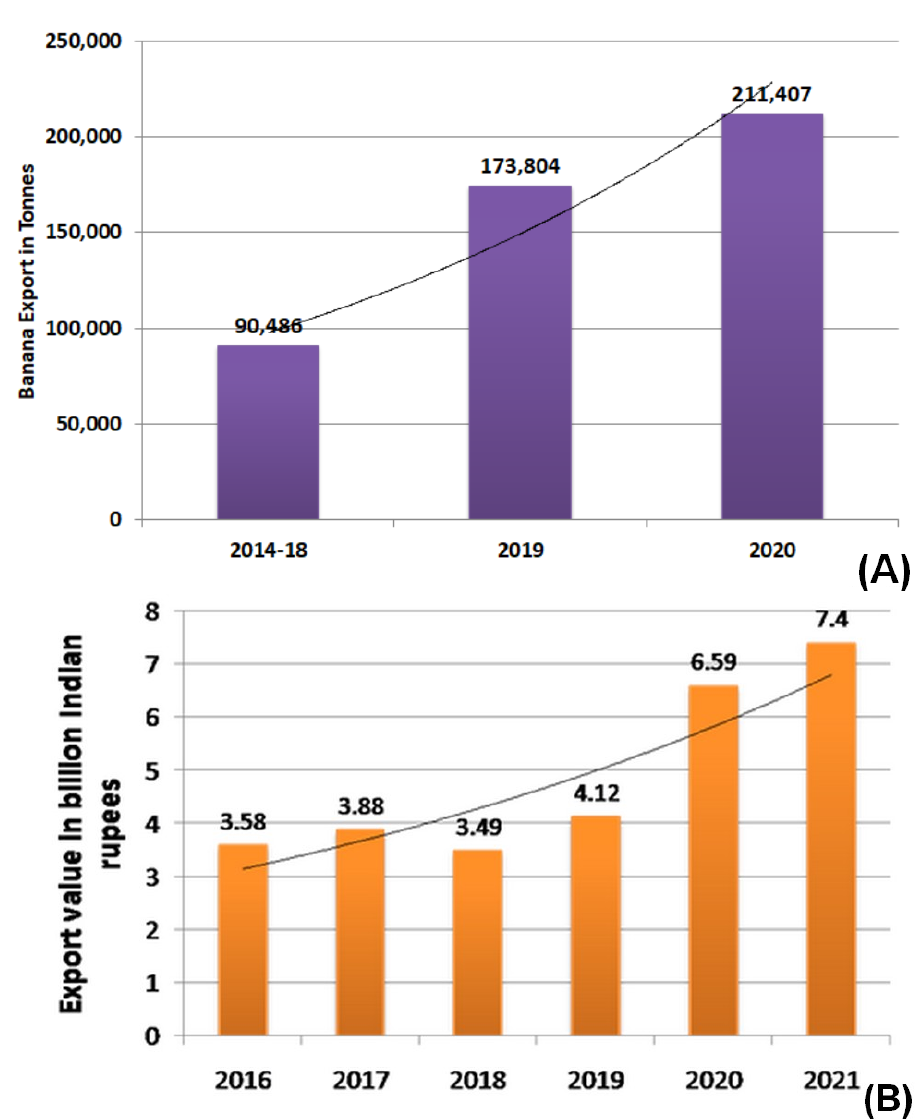
Figure 3. ( A ) FAO-2021 preliminary results on the banana market review for 2020. ( B ) Export value 178 of fresh bananas from India, Fiscal Years 2016–2021 (Published by Statista Research Department, of fresh bananas from India, Fiscal Years 2016 – 2021 (Published by Statista Research Department, 17 179 17 March March 2022).